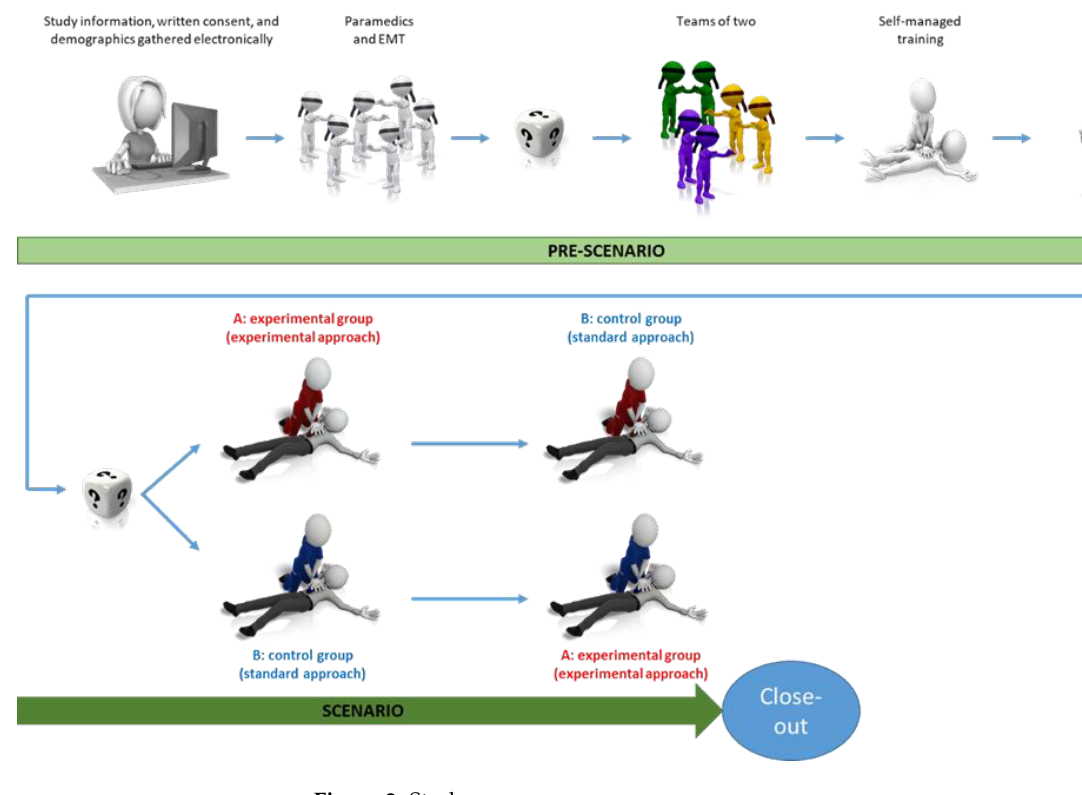
Figure 2. Study sequence. Table 1. Trial schedule.